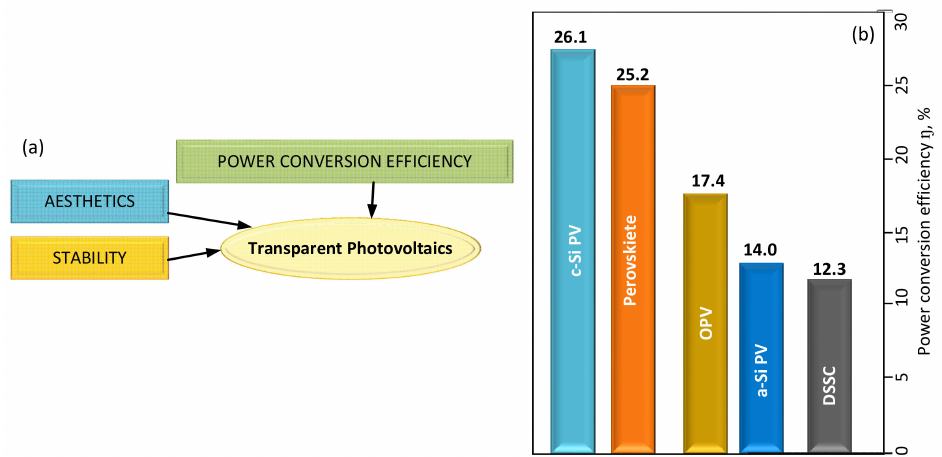
Figure 9. The perspective of the development of transparent photovoltaics: ( a ) classification of features, ( b ) classification of photoconversion efficiency of cells